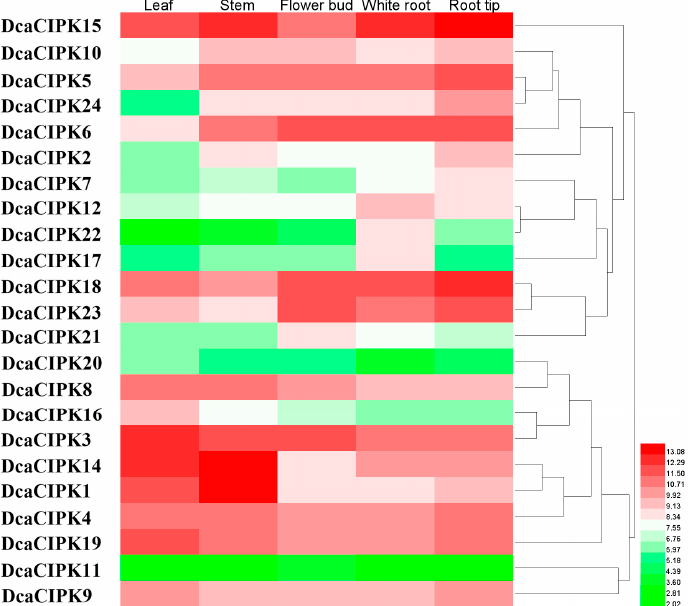
Figure 4. Heatmap of expression profiles for Dca CIPK genes in different tissues. Read-count values were normalized with logarithm base two. The scale represents the relative signal intensity of read-count values.